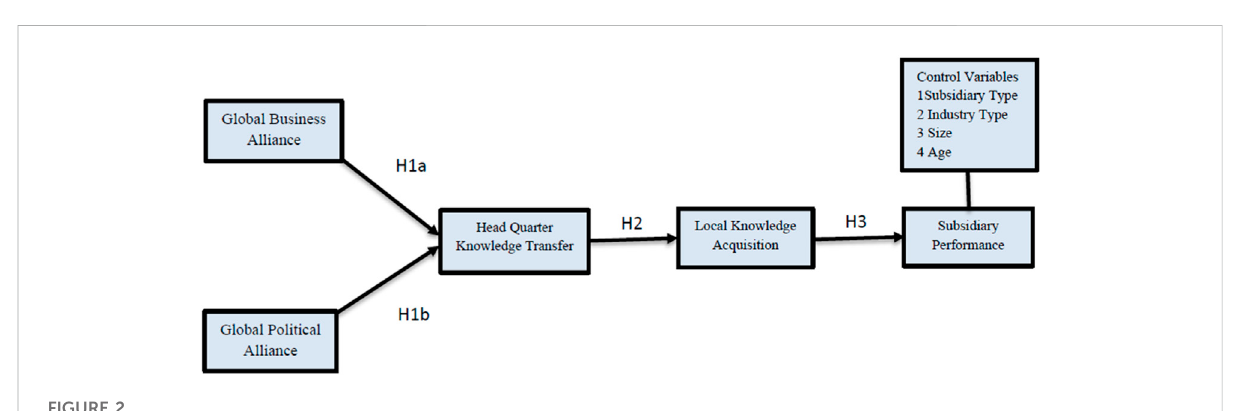
FIGURE 2 Conceptual framework model of knowledge